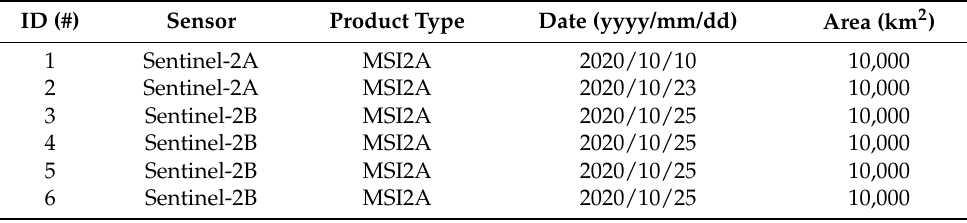
Table 1. Detailed information about the Sentinel-2 images used for this study. The MSI2A instrument provides bottom-of-atmosphere (BOA) reflectance values for the Sentinel-2 images. ID